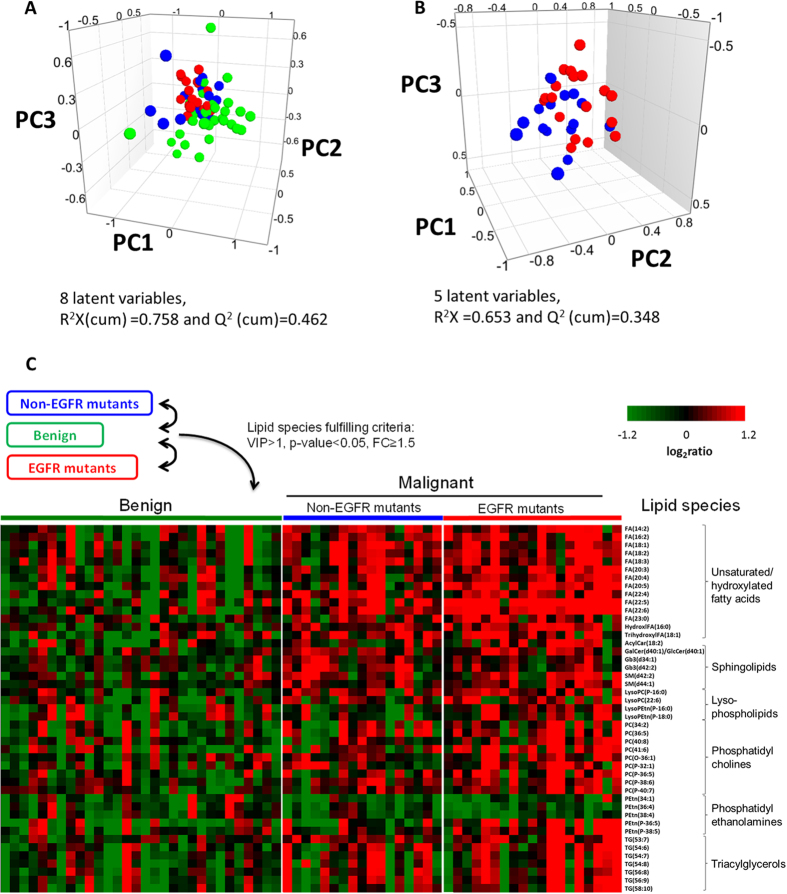
Principal component analysis scores plots for (A) benign (n = 30) and malignant lung PE (n = 36), and the PE of (B) EGFR mutant (n = 19) and non-EGFR mutant (n = 17) collected from the malignant patients. Green, blue and red circles represent the benign, malignant non-EGFR mutant and malignant EGFR mutant PE respectively. (C) Heat map of differential lipid metabolites derived from individual pairwise comparisons between benign, non-EGFR mutant and EGFR mutant PE samples. All represented species are statistically significant (VIP > 1, p-value < 0.05, fold change (FC) ≥ 1.5) for at least one of the pairwise comparisons. Metabolites are grouped according to their lipid classes.